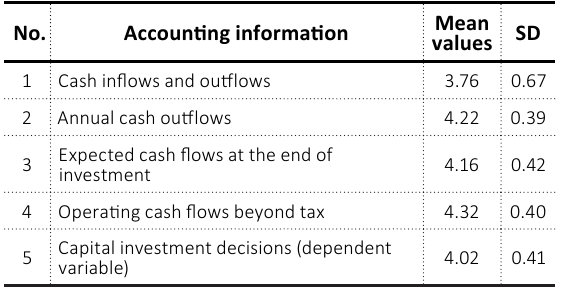
Table 5. Mean and standard deviation